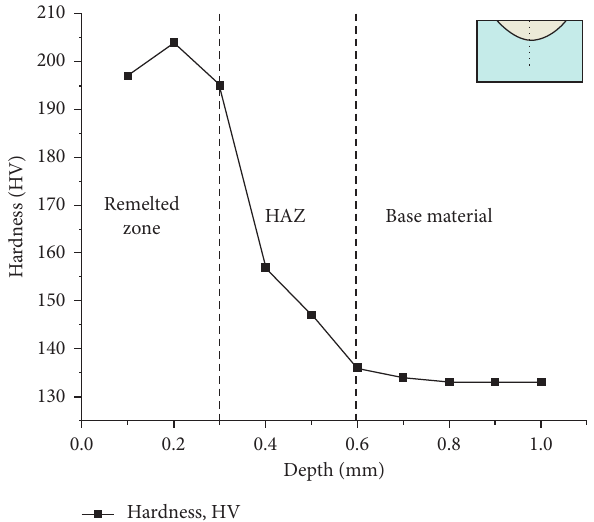
Figure 8: Microhardness distribution in the laser-treated